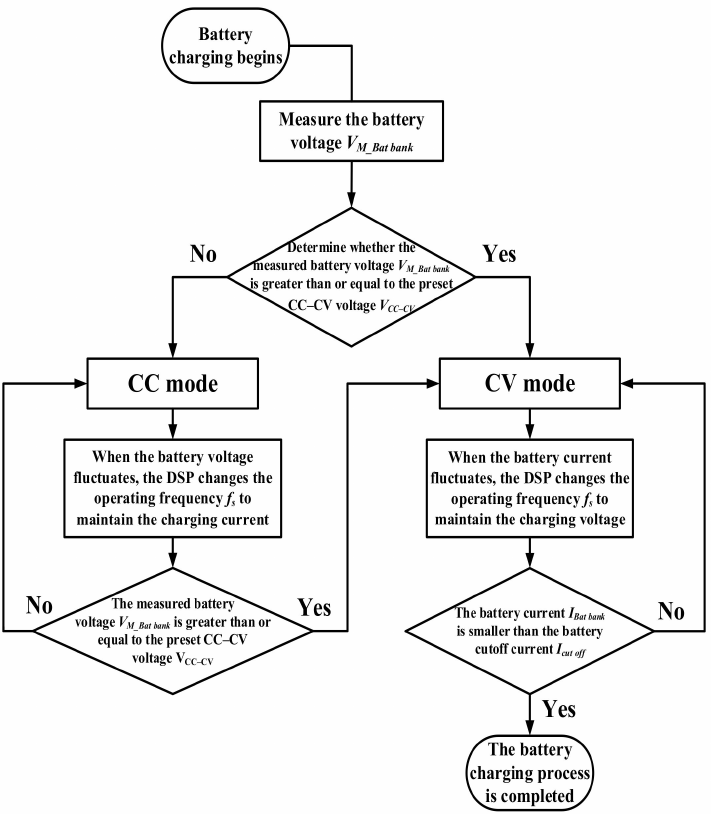
Figure 13. Flowchart of the proposed CC–CV battery energy storage system charging method.